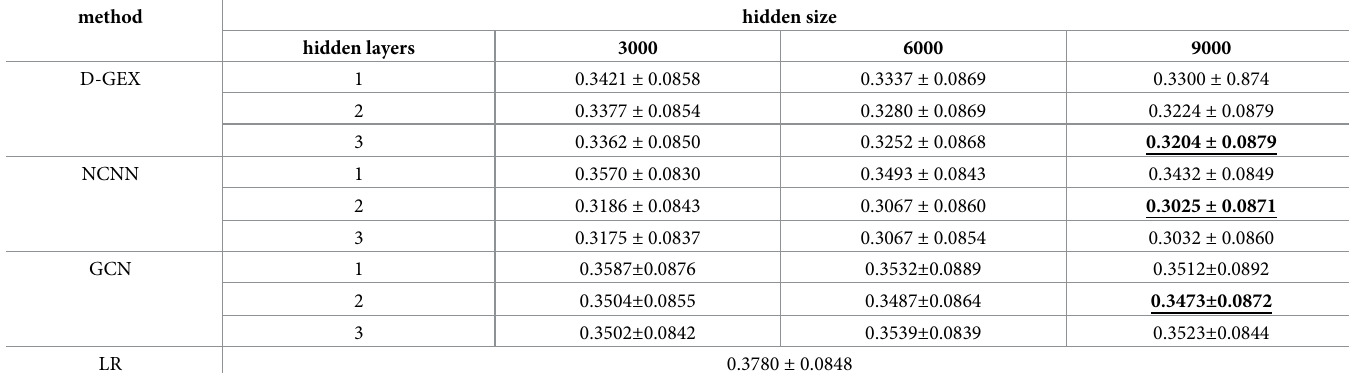
Table 1. MAE comparison between D-GEX and NCNN model in the prediction of GEO data when varying the number of hidden layers and hidden size. method hidden